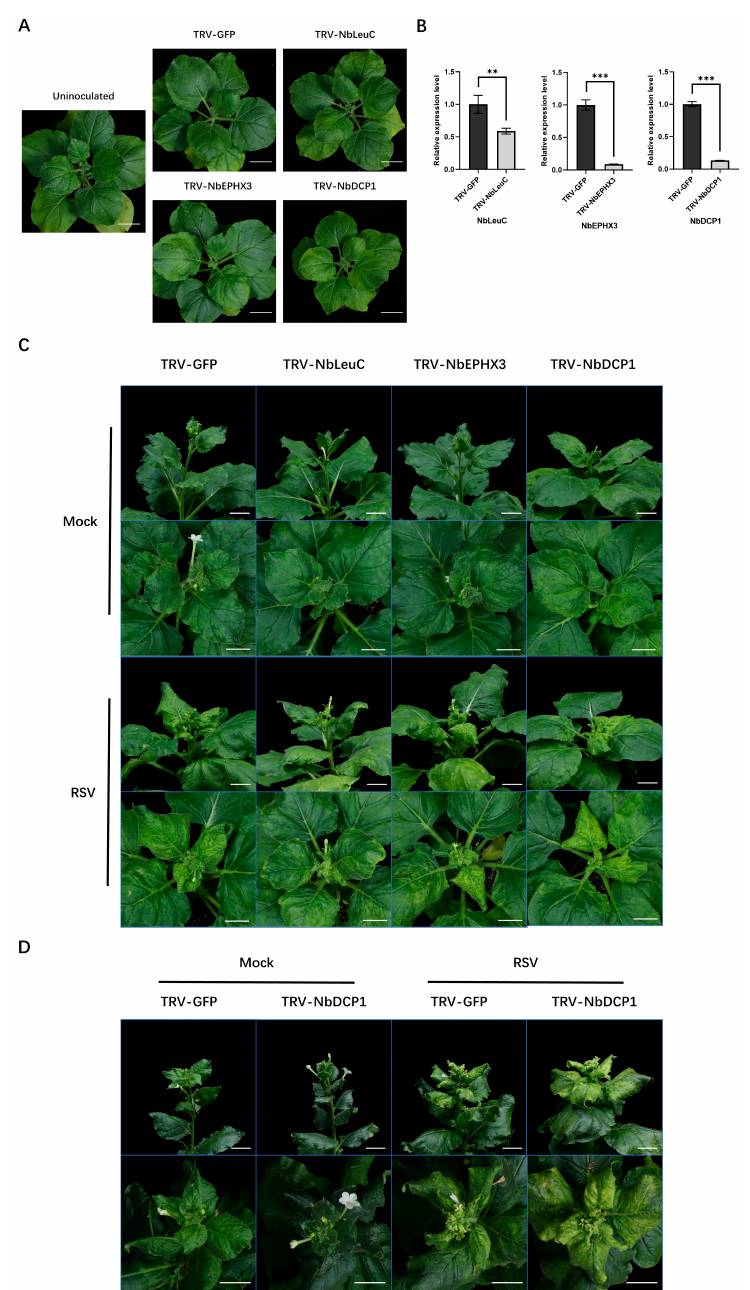
Figure 5. Functions analysis of proteins with DUSs during RSV infection. ( A ) The growth state of healthy N. benthamiana and N. benthamiana infected with TRV-GFP, TRV-NbLeuC, TRV-NbEPHX3, TRV-NbDCP1 at 10 dpi. Bars, 3 cm. ( B ) RT-qPCR analysis of the silencing efficiency of NbLeuC, NbEPHX3 and NbDCP1 in TRV-NbLeuC, TRV-NbEPHX3 and TRV-NbDCP1 pre-inoculated N. benthamiana . The total RNA of the leaf samples from TRV-GFP, TRV-NbLeuC, TRV-NbEPHX3 and TRV-NbDCP1 pre-inoculated N. benthamiana plants were extracted for RT-qPCR analyses at 10 dpi. NbActin served as an internal reference in relative quantification. The values represent the means of the expression levels ± SD relative to the TRV-GFP control plants (n = 3 biological replicates). Data were analyzed by Student’s t test, and asterisks denote significant differences between TRV-GFP and TRV-NbLeuC, TRV-NbEPHX3 or TRV-NbDCP1 pre-inoculated plants (two-tailed, ** p < 0.01, *** p < 0.001). ( C ) The viral symptom comparison between N. benthamiana plants pre-inoculated with TRV-GFP (control) and TRV-NbLeuC, TRV-NbEPHX3 or TRV-NbDCP1 at 15 dpi. Bars, 2 cm. ( D ) The viral symptom comparison between N. benthamiana plants pre-inoculated with TRV-GFP (control) and TRV-NbDCP1 at 30 dpi. Bars, 2